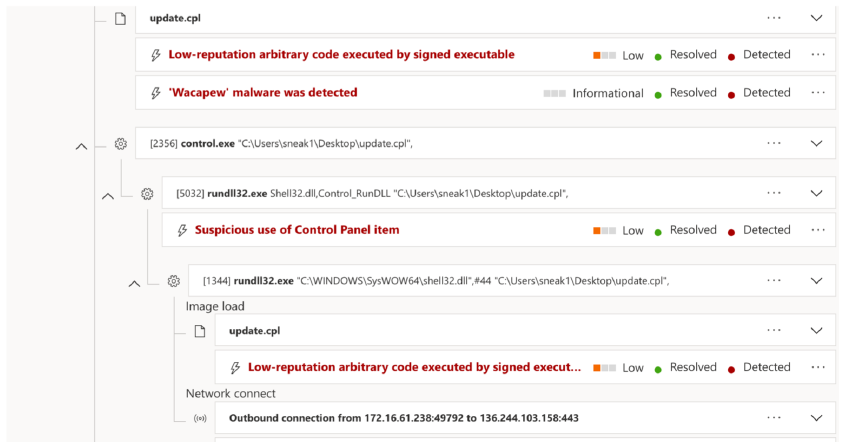
Figure 28. Details about the alerts produced from ATP.